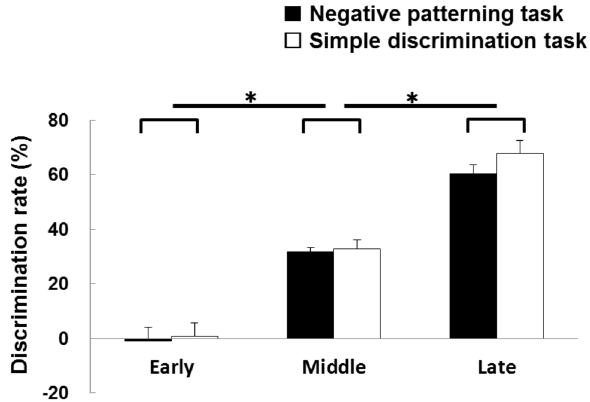
followed by middle and early stages in both tasks (*: p < 0.05).